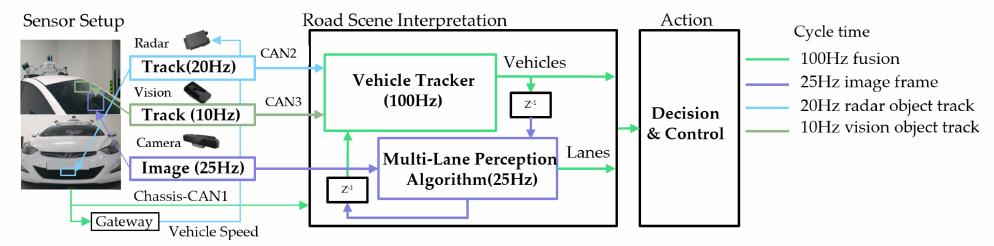
Figure 13. Multi-sensor setup and fusion chart (image obtained from [21]).